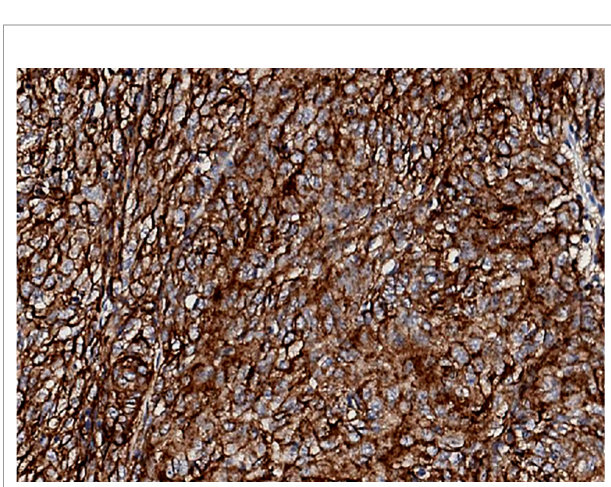
FIGURE 3 | Immunohistochemical staining of tumor cells for PD-LI (22C3) in our patient. PD-L1 expression was 90%.